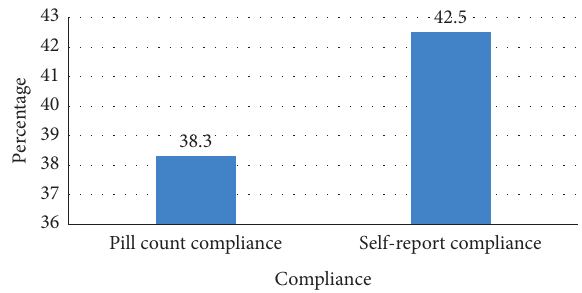
Figure 3: Compliance level with iron-folate supplement among pregnant women attending antenatal care and taking iron-folate, Shalla district health facilities, West Arsi Zone, Southwest Ethiopia, 2019 ( N �